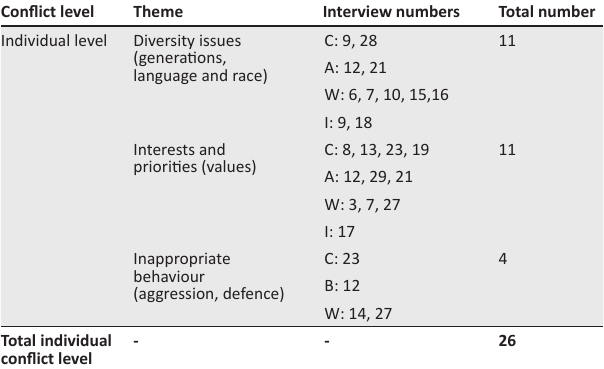
TABLE 1: Individual level conflict of women leaders.